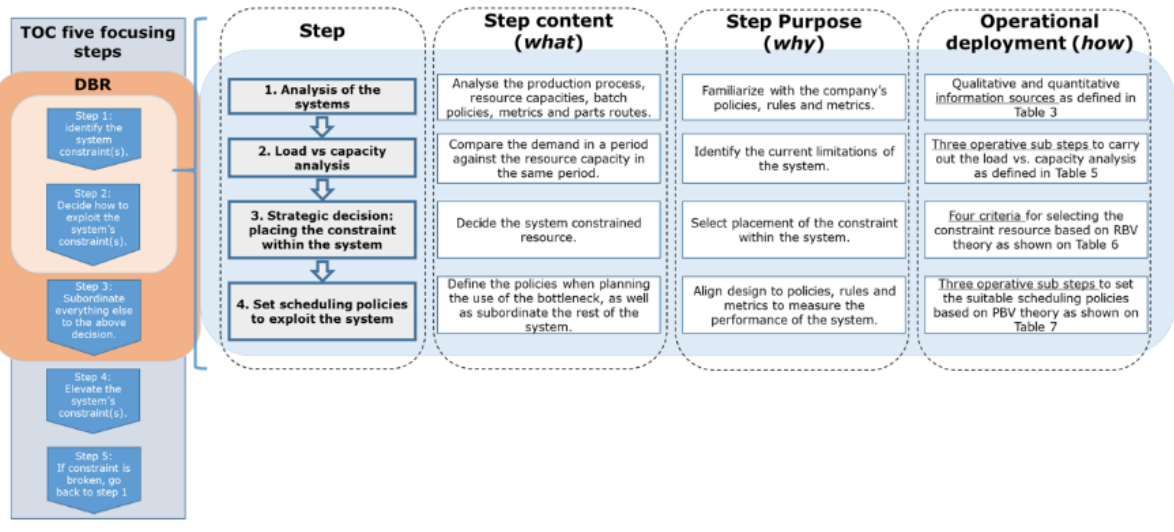
Figure 4. Systematic process for TOC steps 1 and 2: Process steps, step content, step purpose and operational deployment. Based and extended of (Lizarralde et al.,